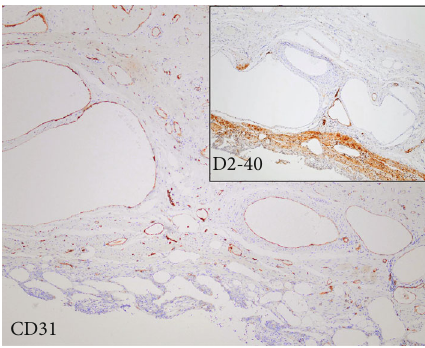
Figure 2: Immunohistochemistry of angiodysplasia. The endothelial lining was con fi rmed immunohistochemically with positive staining for CD31 and CD34 (not shown), while staining for podoplanin (D2-40) monoclonal antibody was negative (inset microphotograph) (immunohistochemistry;